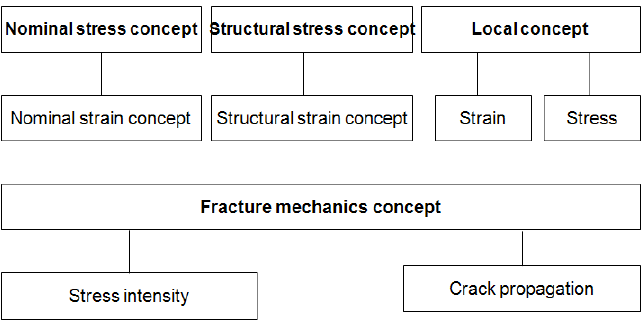
Figure 5: Overview of fatigue design concepts for welded